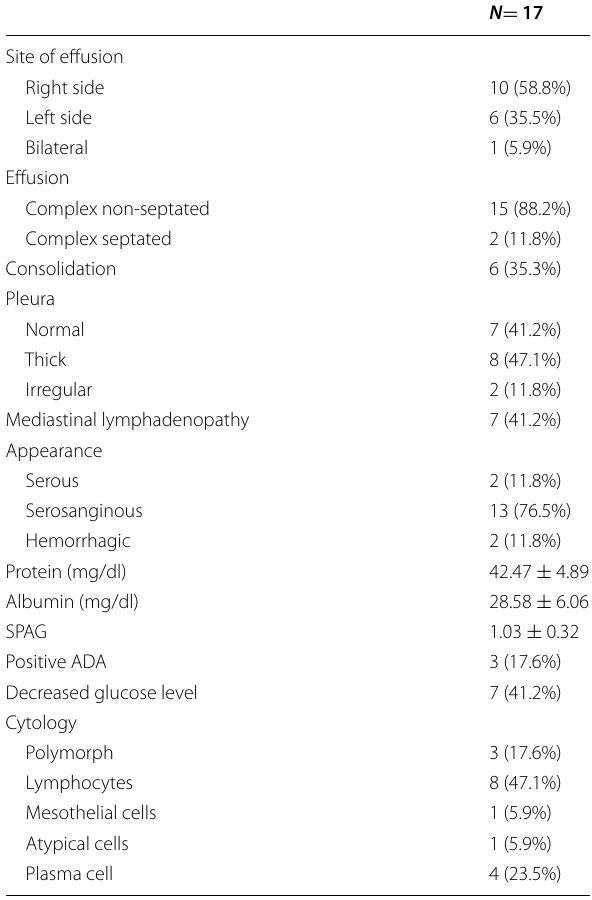
Table 5 The radiological data and pleural fluid analysis of patients with IgG4 related effusion